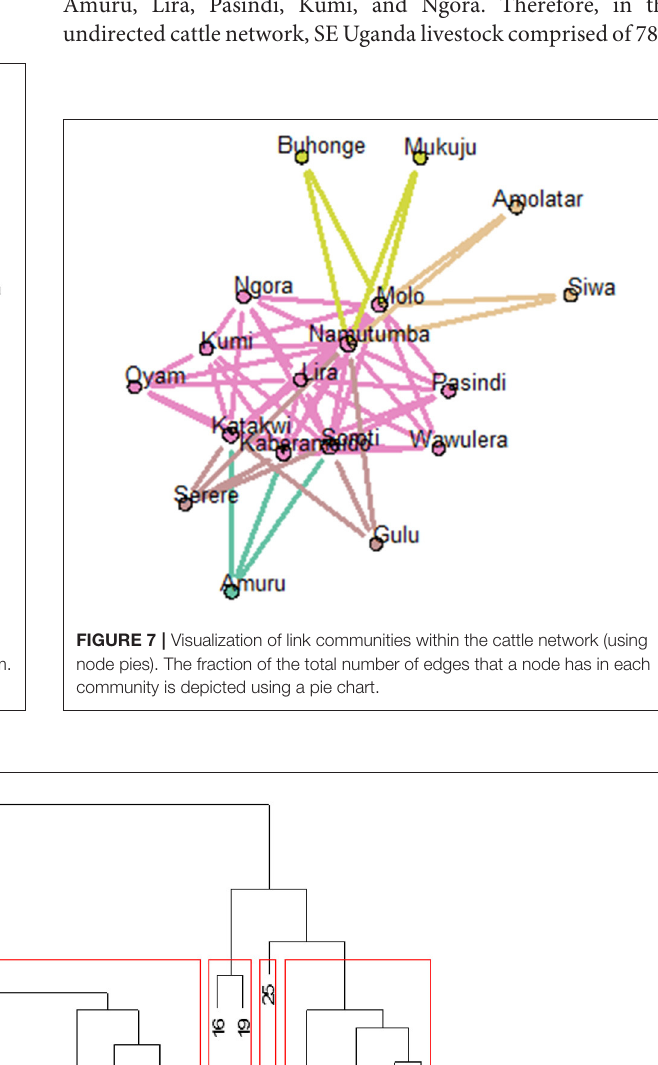
Frontiers in Veterinary Science |